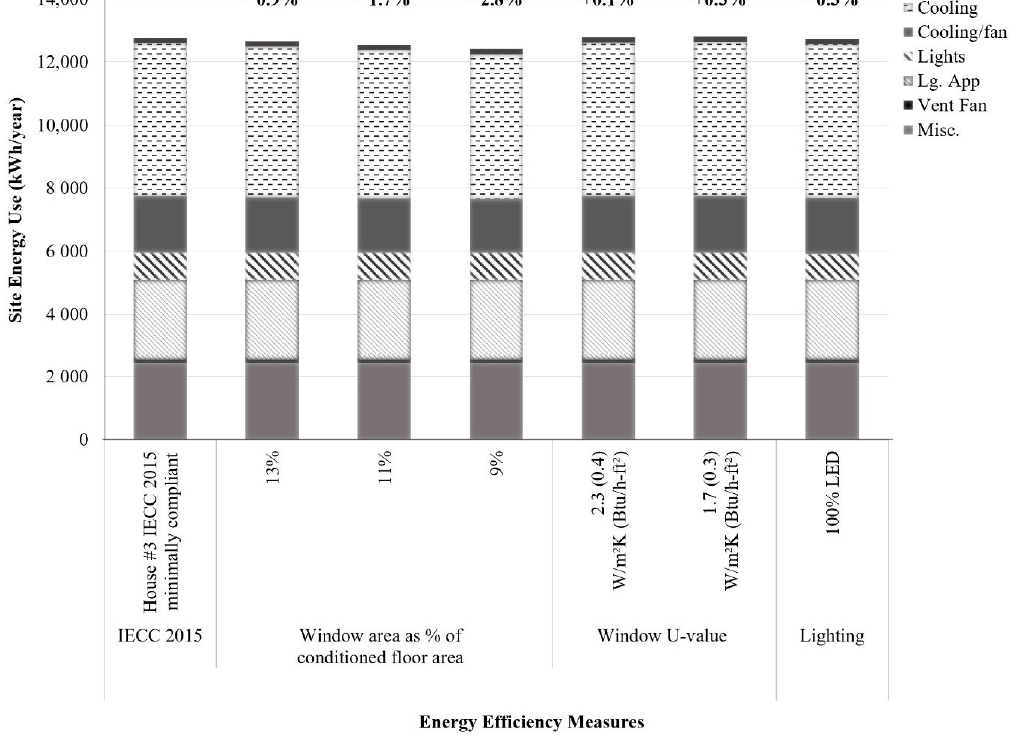
Figure 3. Simulated annual site energy (kWh / year) consumption for parametric fenestration and Figure3 lighting energy e ffi ciency measures vs. the IECC 2015 baseline. Percent changes in annual energy use are